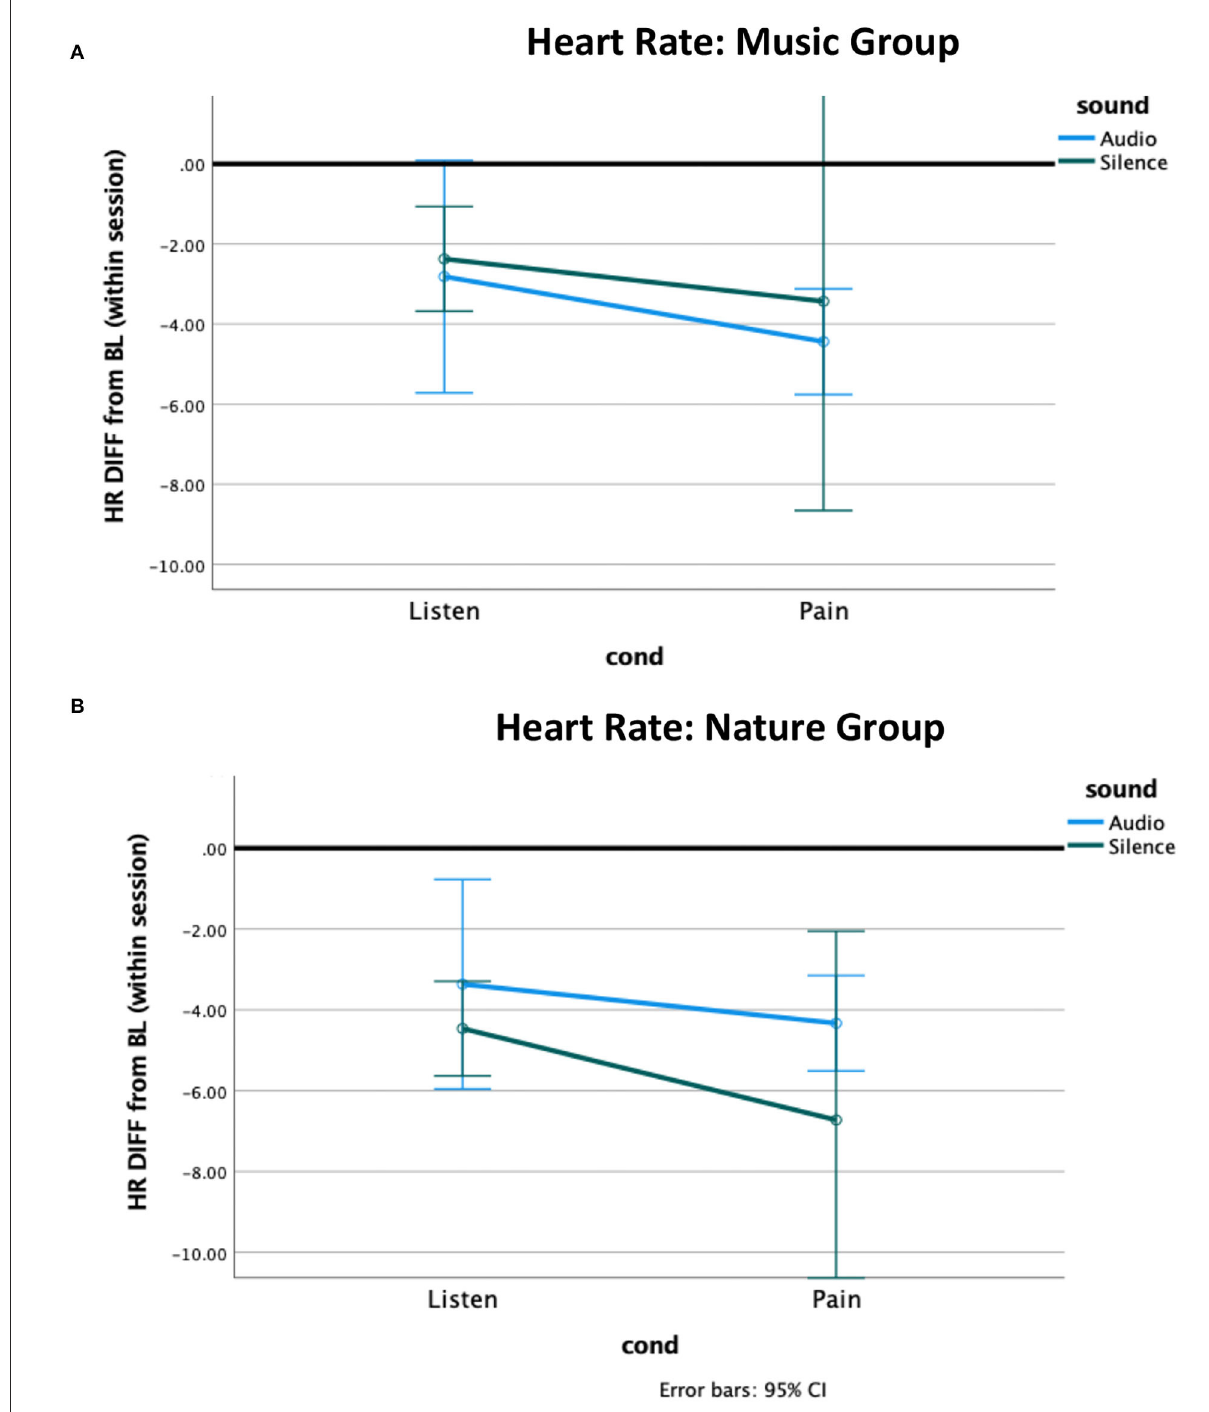
FIGURE2 Heart rate difference from within-session baseline. The heart rate of both groups decreased from baseline to the listening condition and further decreased during pain. (A) The Music group had a greater pain-related decrease to music compared to silence, and (B) the Nature group had a greater pain-related decrease to silence compared to nature